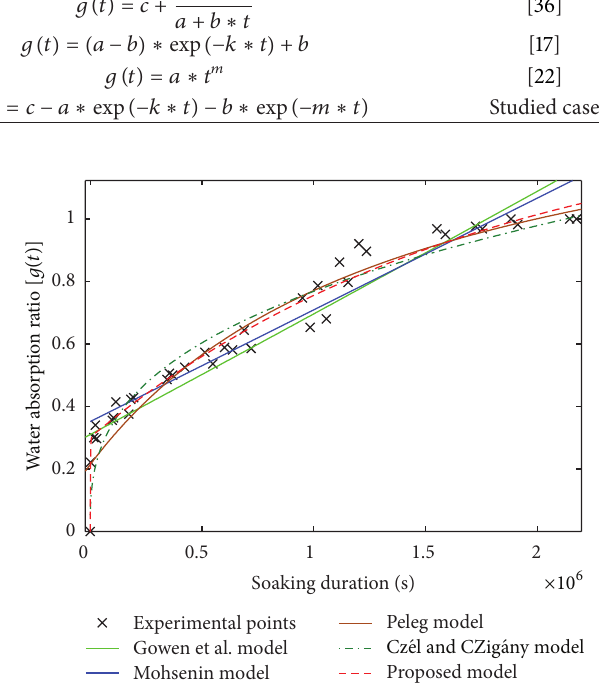
Figure 4: Curves of the various studied models of sample PL-1/4-